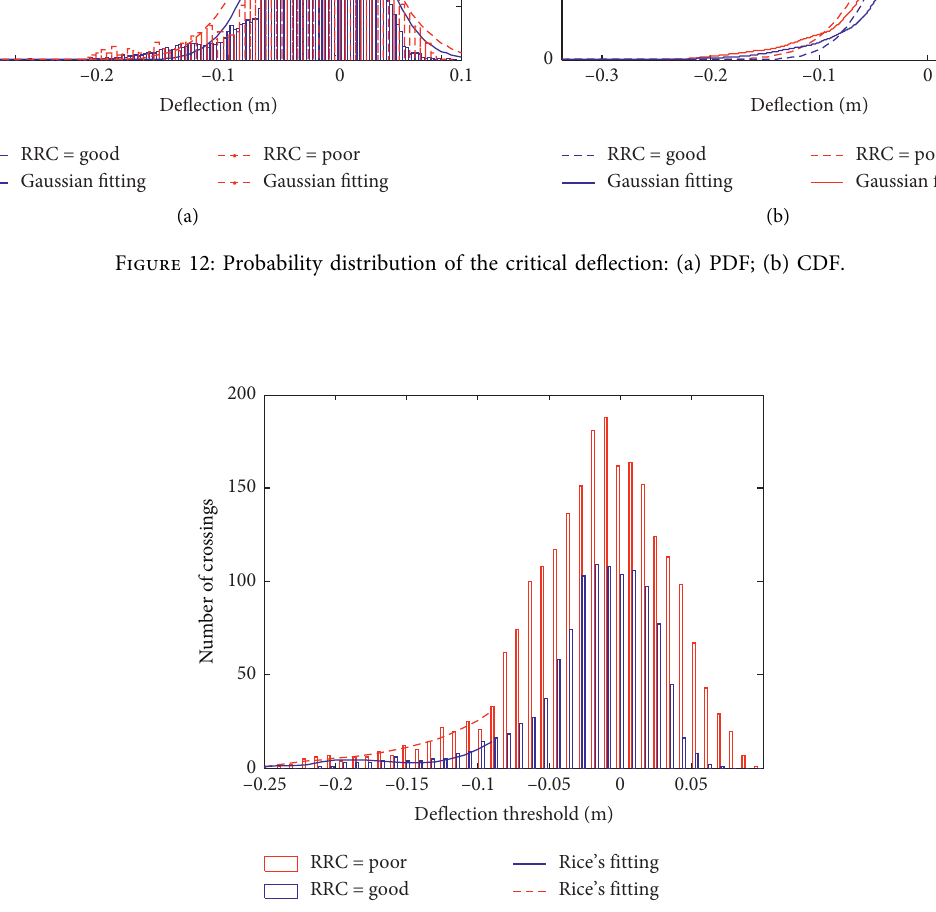
Figure 13: Histograms and fitting to the number of